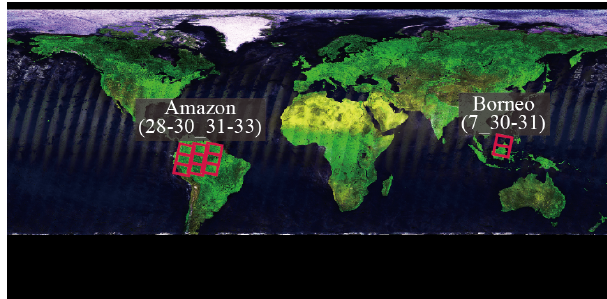
Figure 4. Study areas in Borneo and the Amazon. CAI path and frame system: XX_YY (XX indicates CAI path number and YY indicates CAI frame number). Red rectangles indicate the locations of CAI frames. The background image was generated from the CAI L3 global reflectance distribution product (15 June to 14 July